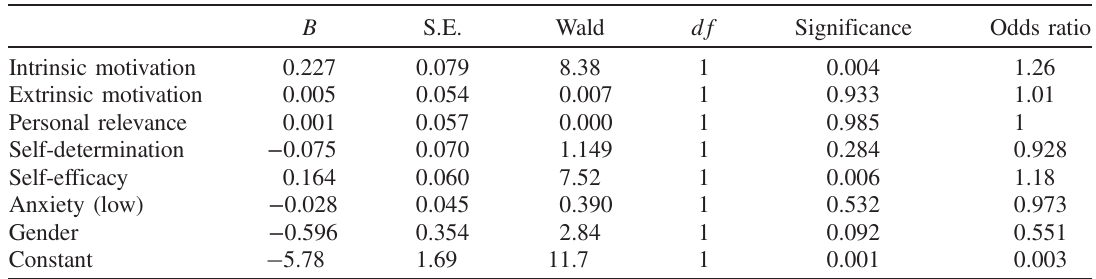
TABLE VIII. Motivation impact on undergraduate student choice of graduate school (career or graduate school).